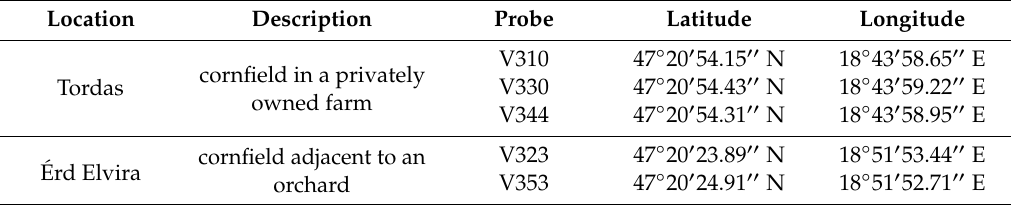
Table 1. The geographical location of the test sites and ZooLog KLP probes.